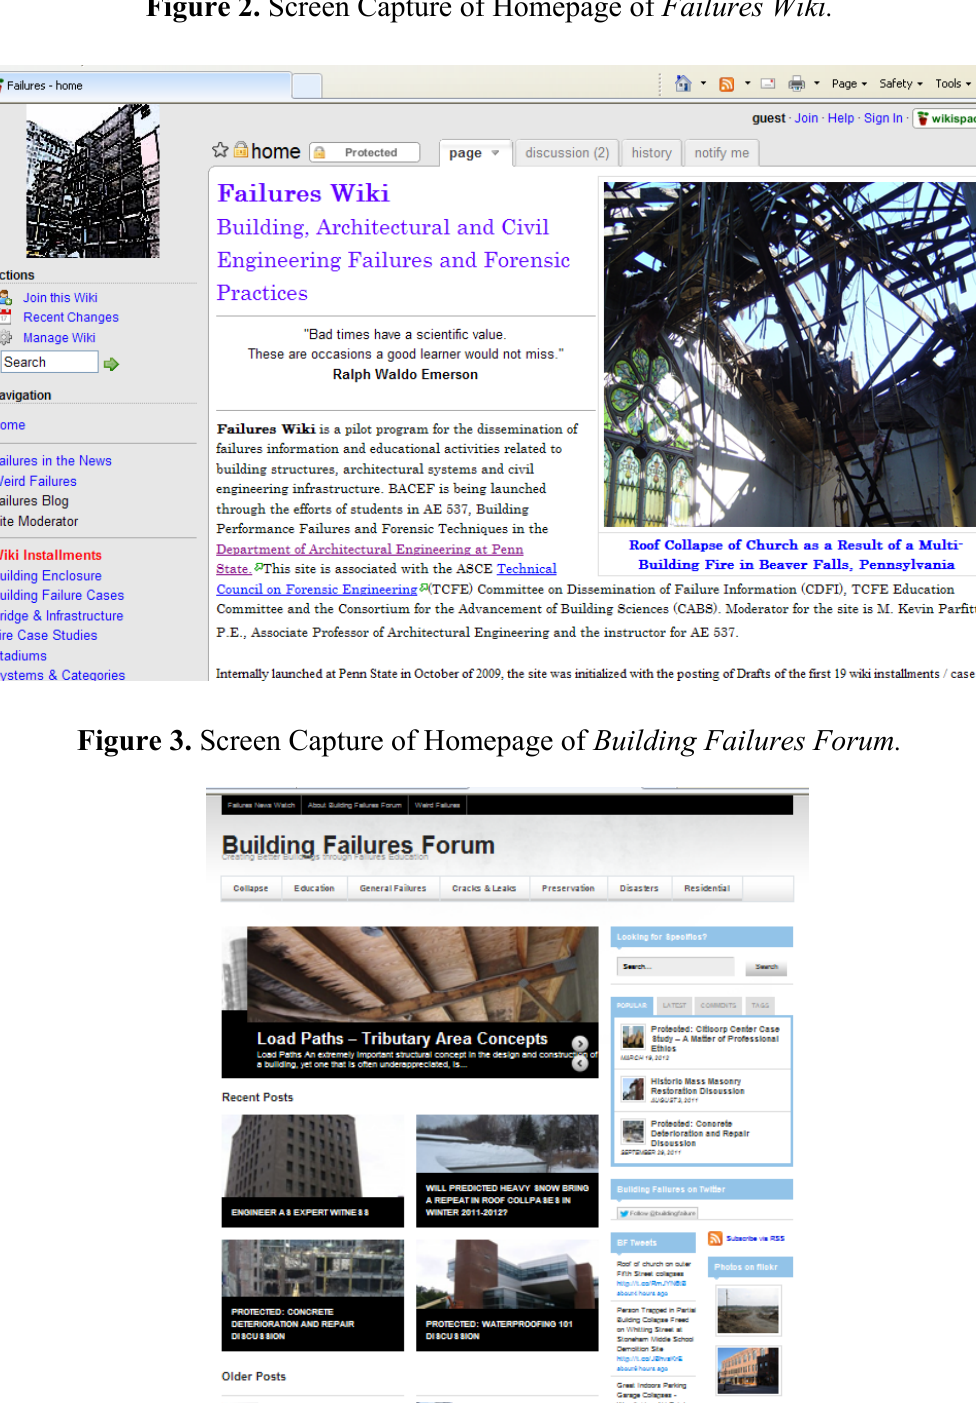
Figure 2. Screen Capture of Homepage of Failures Wiki.